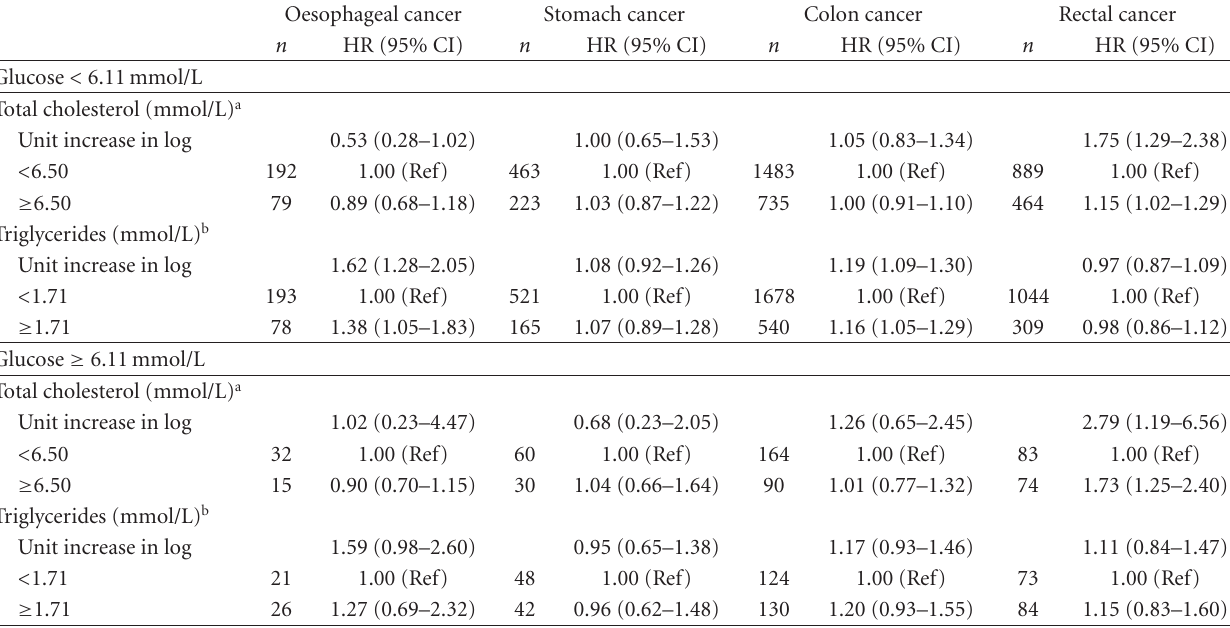
Table 4: Hazard ratios and 95% confidence intervals for GI cancer for lipid components as continuous variables and based on cut-o ff points used in cardiovascular disease prevention, stratified by glucose levels, adjusted for age, gender, SES, fasting status, glucose (continuous), total cholesterol (continuous), and triglycerides